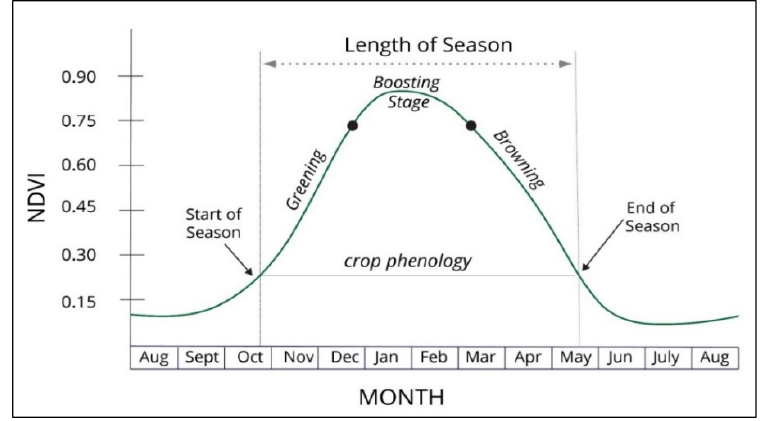
Figure 4. An example of single growing season and related phenological measures analysed through NDVI.